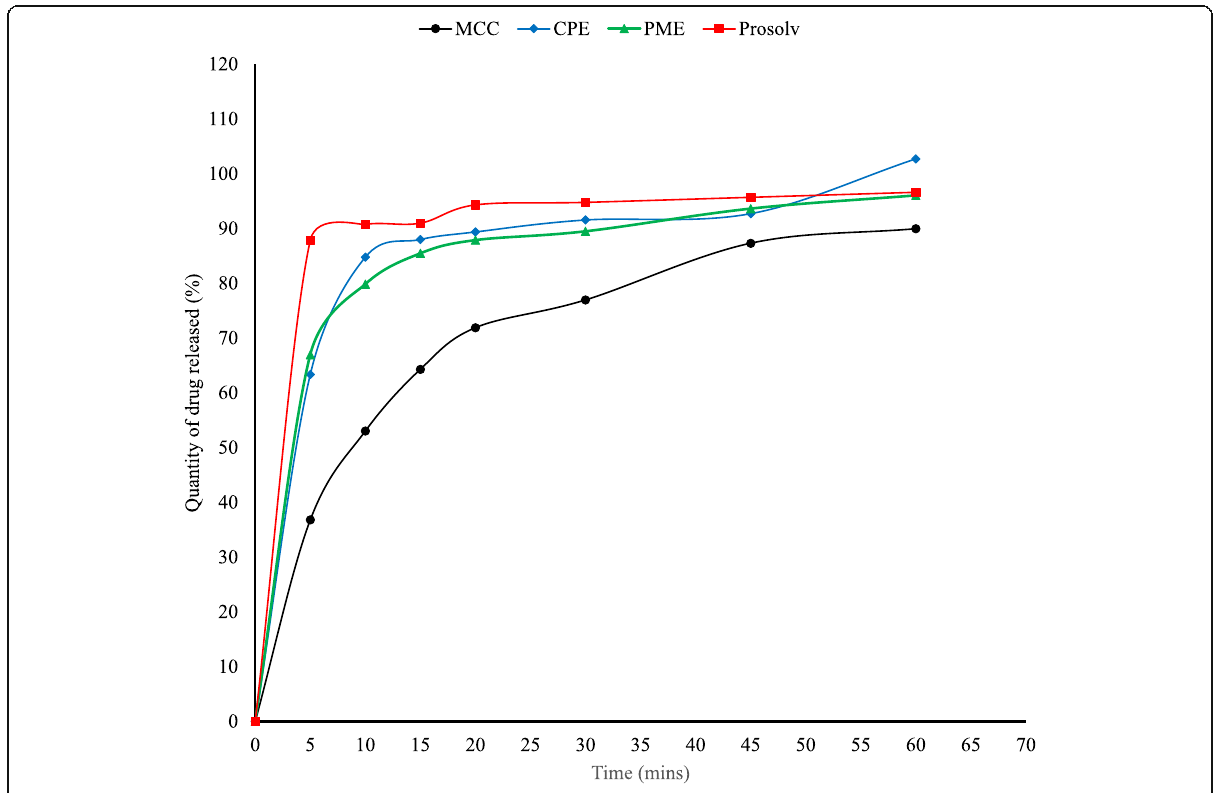
Fig. 4 Drug release profile of MCC, CPE, PME, and Prosolv showing the amount of drug released with